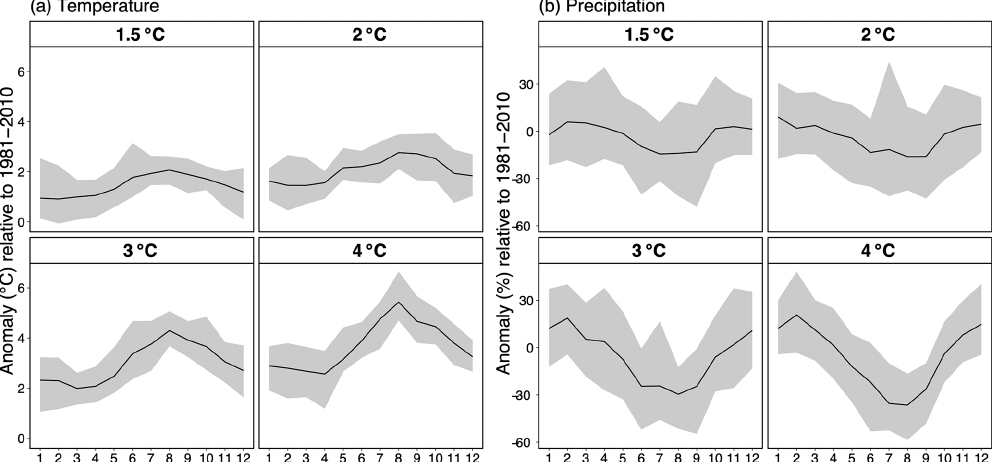
Figure 10. Projected percentage change in monthly average (a) temperature and (b) precipitation relative to 1981–2010 from the UKCP18 re- gional projections at four warming levels averaged across the selected catchments. The shaded region represents the maximum and minimum range of the projected change amongst the 12 regional projections. The solid black line is the ensemble